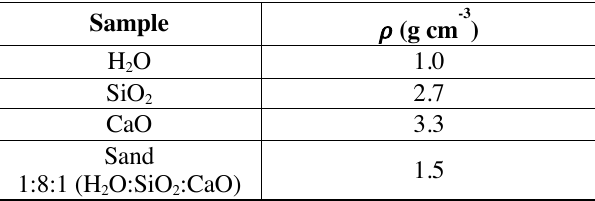
Table 1. Composite sample details.